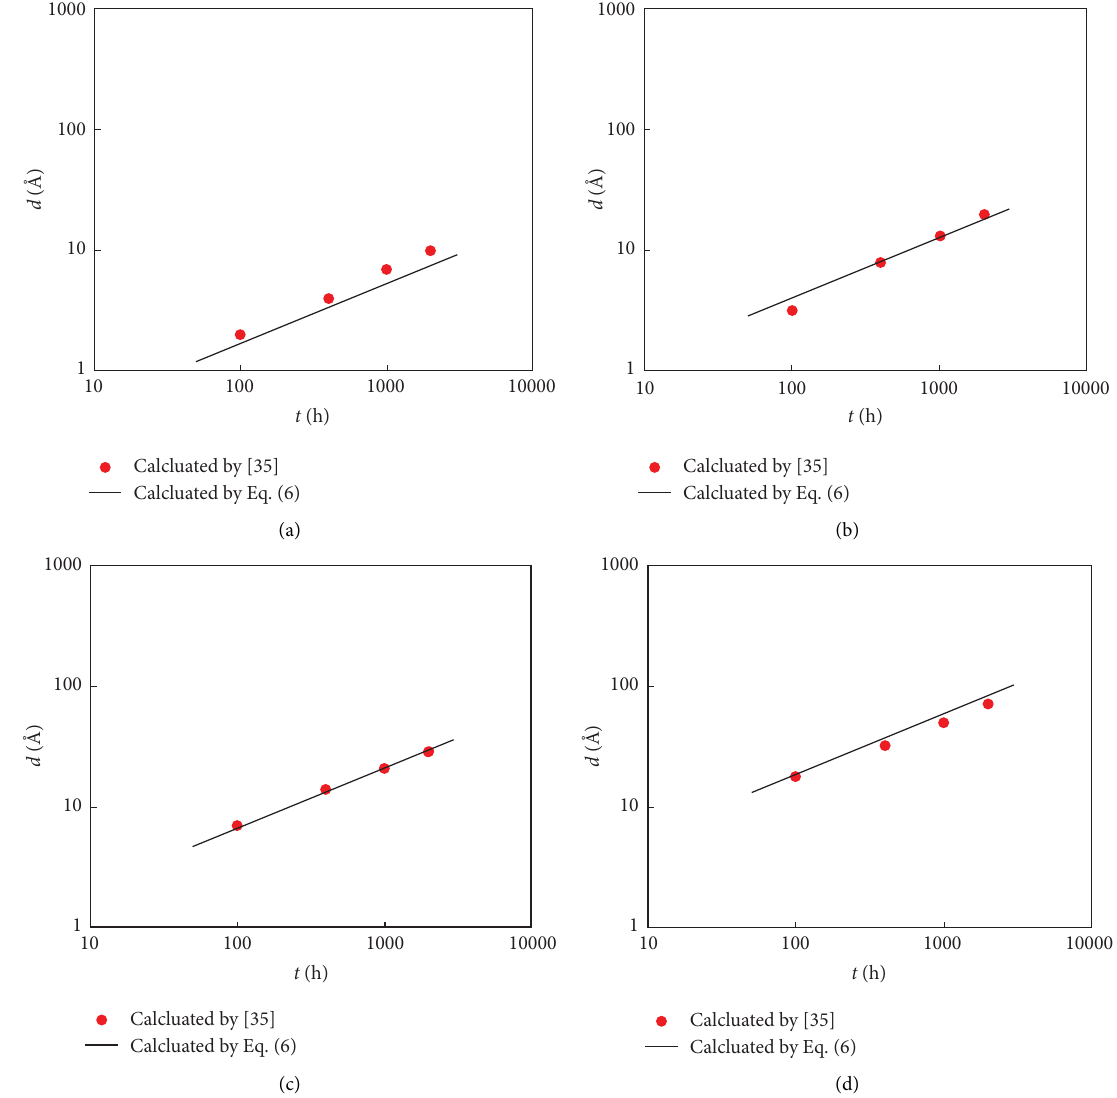
� 0.26, T � 125 ° C; (b) C cu